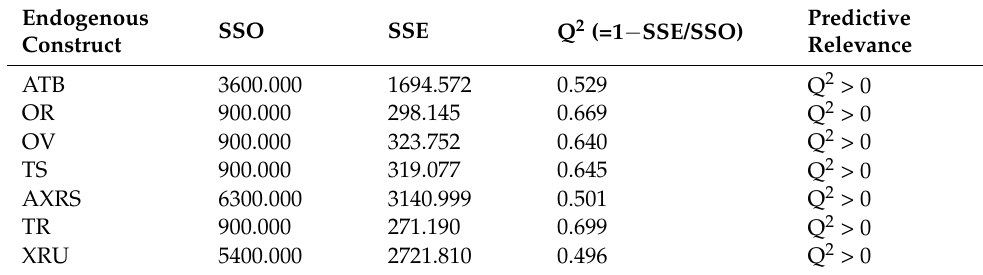
Table 7. Predictive